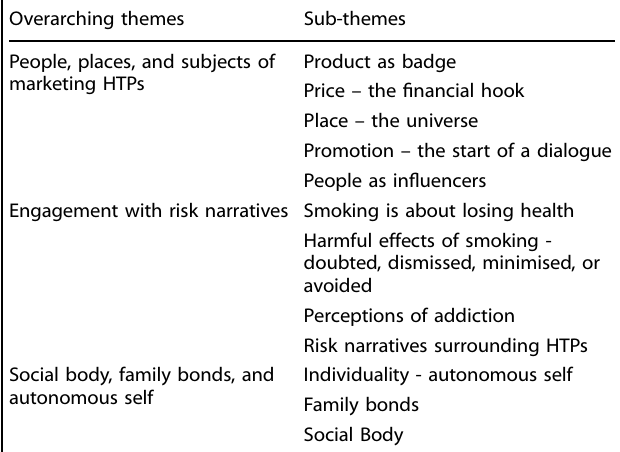
Table 2. Over-arching themes and